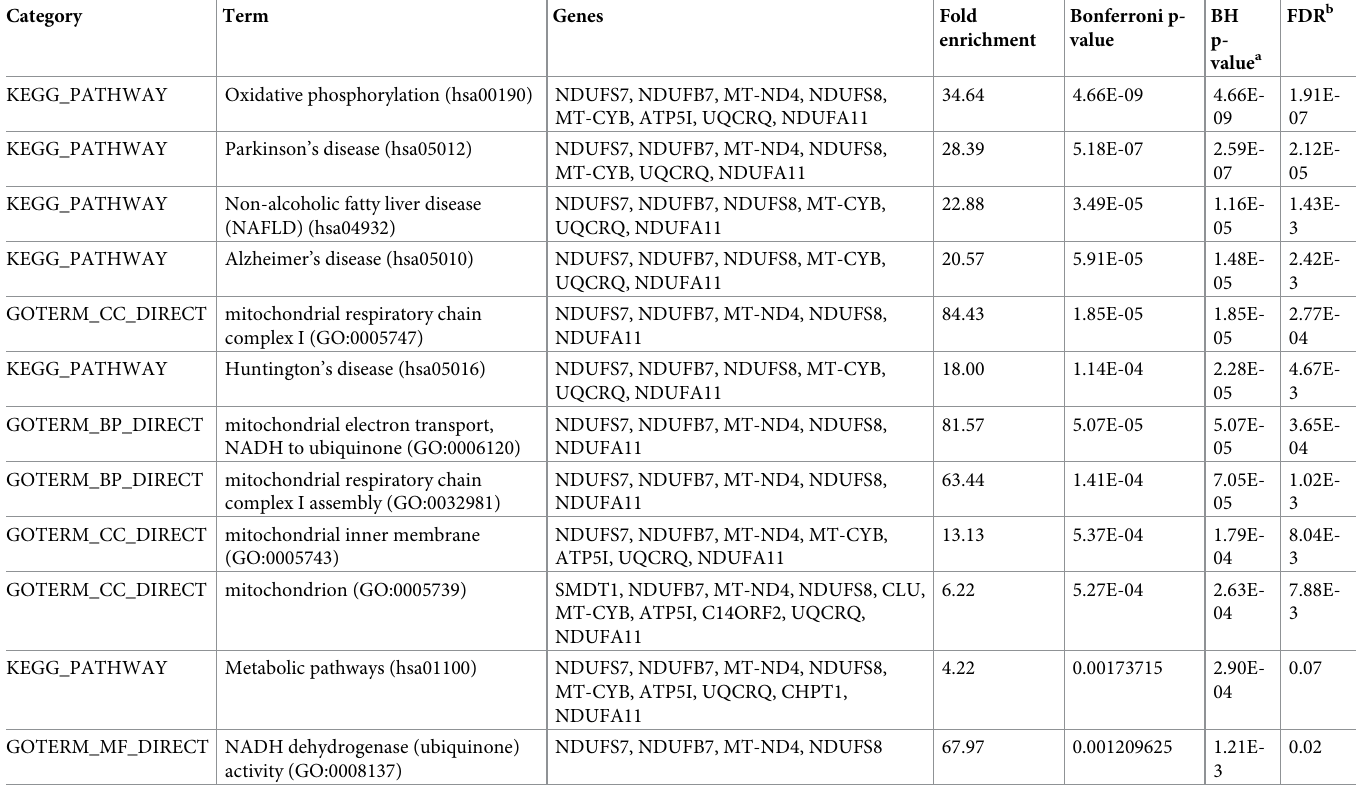
Table 3. GO terms and KEGG pathways significantly enriched in genes upregulated in the 5,000 m individuals.